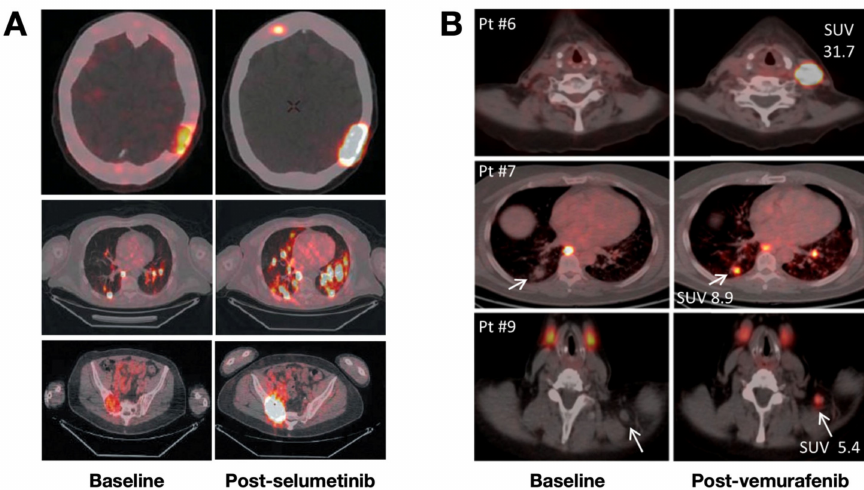
Figure 1. [ 124 I]NaI PET/CT images of patients with RR-DTC or PDTC with or without kinase inhibitors. ( A ) PET/CT images showed enhanced iodine uptake of lesions post-treatment with selumetinib in nearly all previously negative head, lung, and sacroiliac bone metastases. Reproduced with permission from [35], copyright 2013 Massachusetts Medical Society. ( B ) PET/CT images showed enhanced radioiodine uptake of lesions in the neck and lung after treatment with vemu- rafenib, a specific BRAF V600E inhibitor. Reproduced with permission from [36], copyright 2019 Endocrine Society.